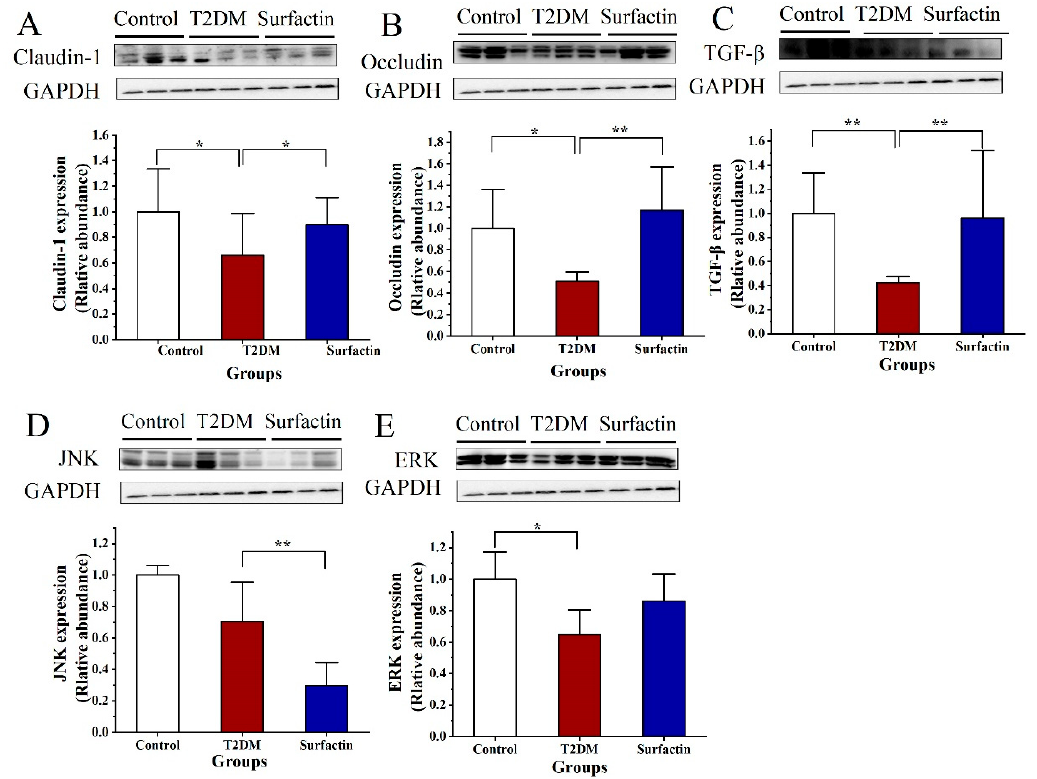
Figure 7. Effect of surfactin on critical protein involved intestinal barrier function and stress in HFD/STZ-induced T2DM mice. The control group represents normal mice fed a basic diet, the T2DM group represents mice with T2DM induced by a 60% fat diet and 30 mg/kg body weight STZ, and the surfactin group represents T2DM mice treated with 80 mg/kg body weight surfactin. The levels of Claudin-1 ( A ), Occludin ( B ), TGF- β ( C ), JNK ( D ) and ERK ( E ). * indicates significant differences at p < 0.05, ** indicates significant differences at p < 0.01.